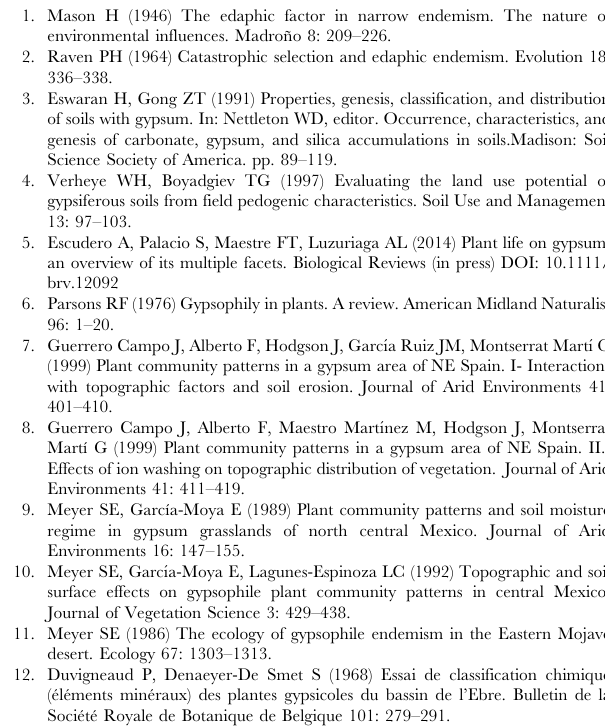
Figure S1 Comparison of FTIR spectra of Ononis tridentata from different sites: a) red line, Chincho´n (Madrid), b) blue line, Villamayor (Zaragoza). (TIF) Figure S2 Normalisation of FTIR spectra. Top – raw spectrum, bottom – after moving average preprocessing and normalisation to within range [-1, 1]. (TIF) Table S1 Average chemical composition of study spe- cies.